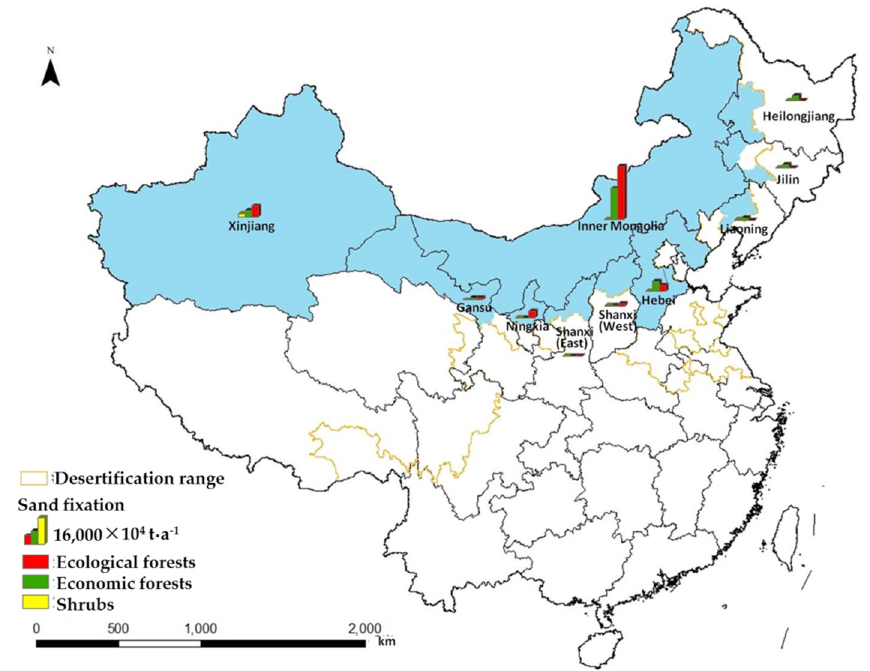
Figure 5. Sand fixation by different forest types.